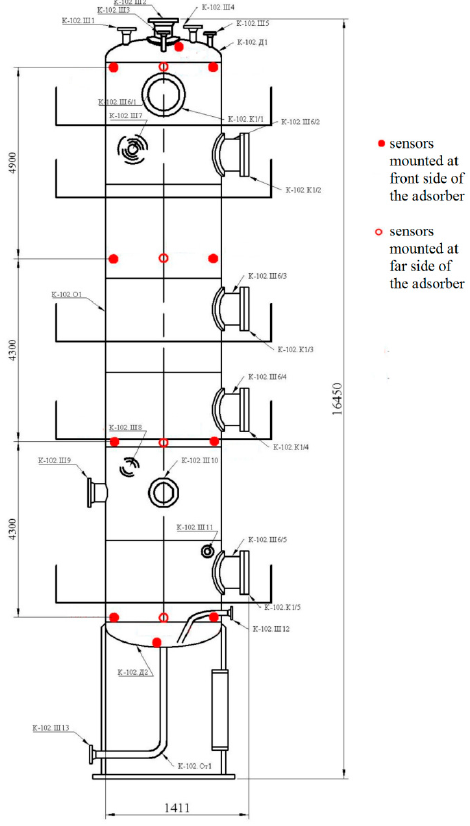
Figure 13. Gas adsorber schematic drawing with places of AE sensors mounting.